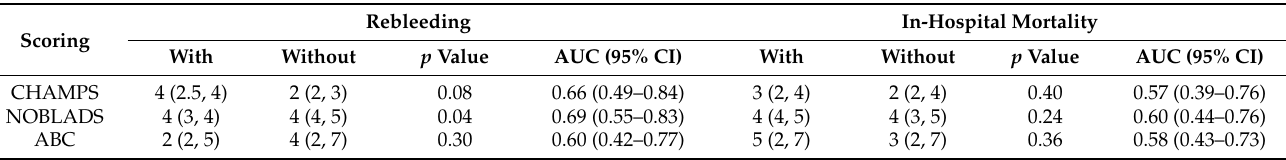
Table 4. Diagnostic performance of 3 scoring systems to predict rebleeding and in-hospital mortality among patients with AHRUs.